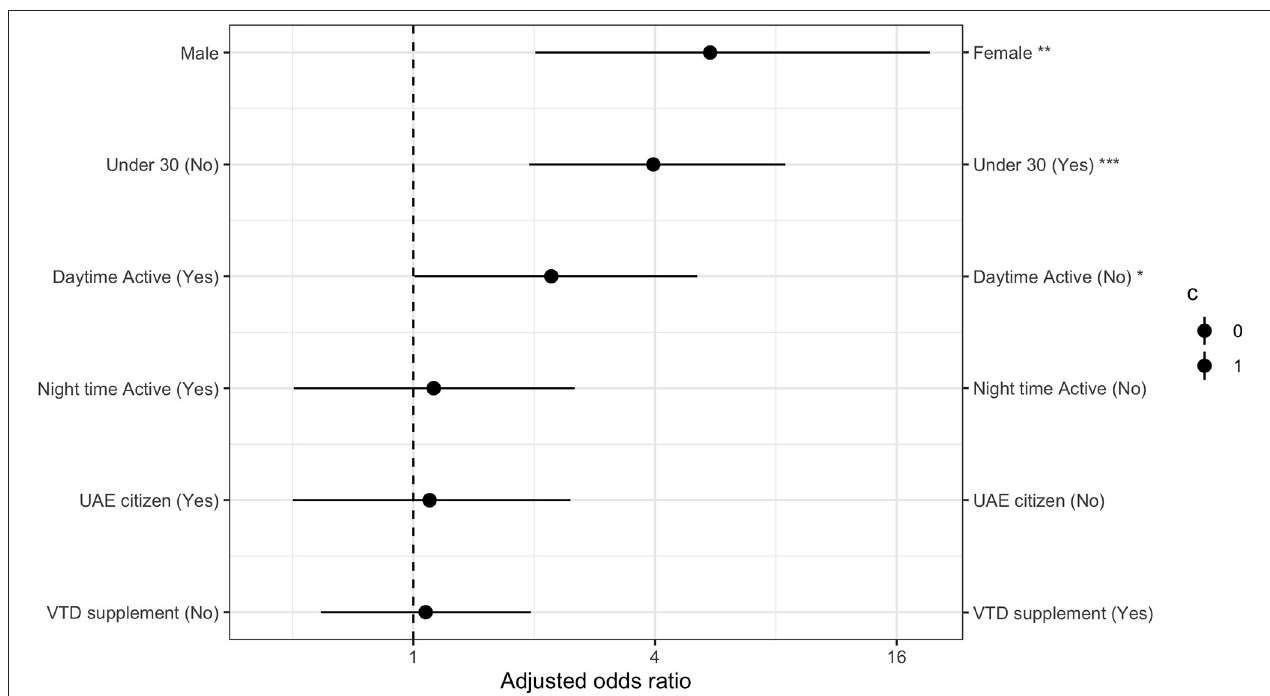
FIGURE 2 | Multivariate logistic regression model analysis for higher risk of clinically significant somatic symptoms with adjusted odds ratios for all